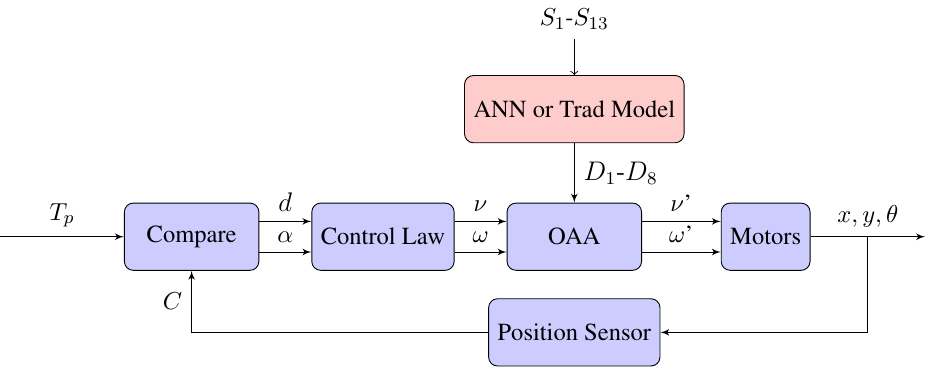
Figure 16. Block diagram of the position control problem